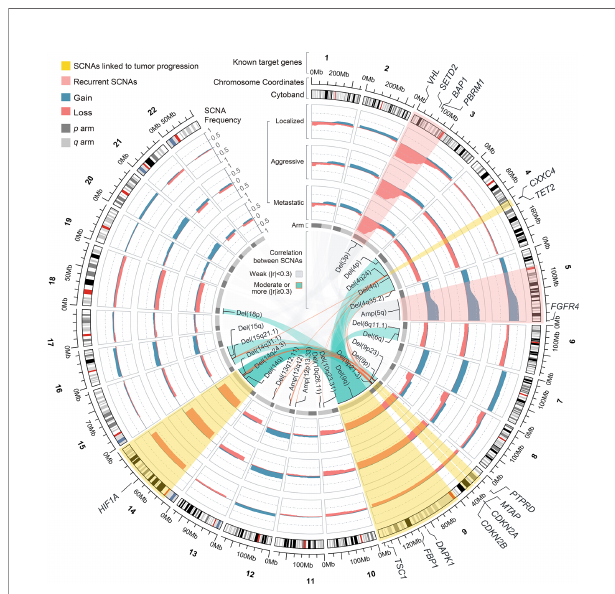
FIGURE 3 | Circular plot showing the recurrent and differential SCNAs and their correlation among phenotypes of ccRCC in TCGA cohort.